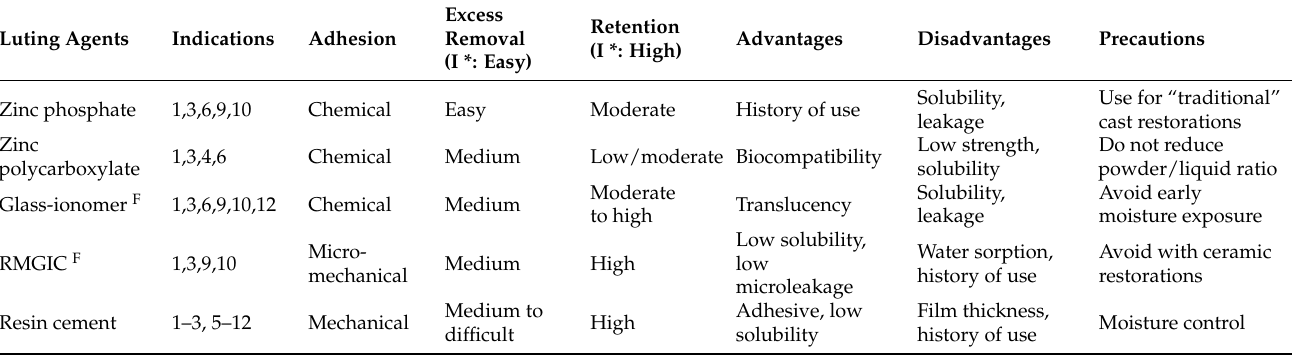
Table 3. Indications, retention, advantages, and precautions of dental luting agents